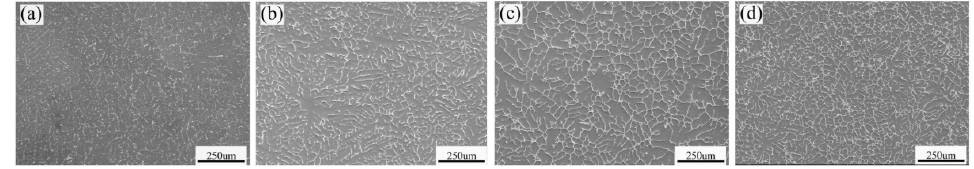
Figure 7. SEM images of the as-cast Mg–Ca–Zn alloys: ( a ) XZ10, ( b ) XZ12, ( c ) XZ15, ( d ) XZ18 [37].